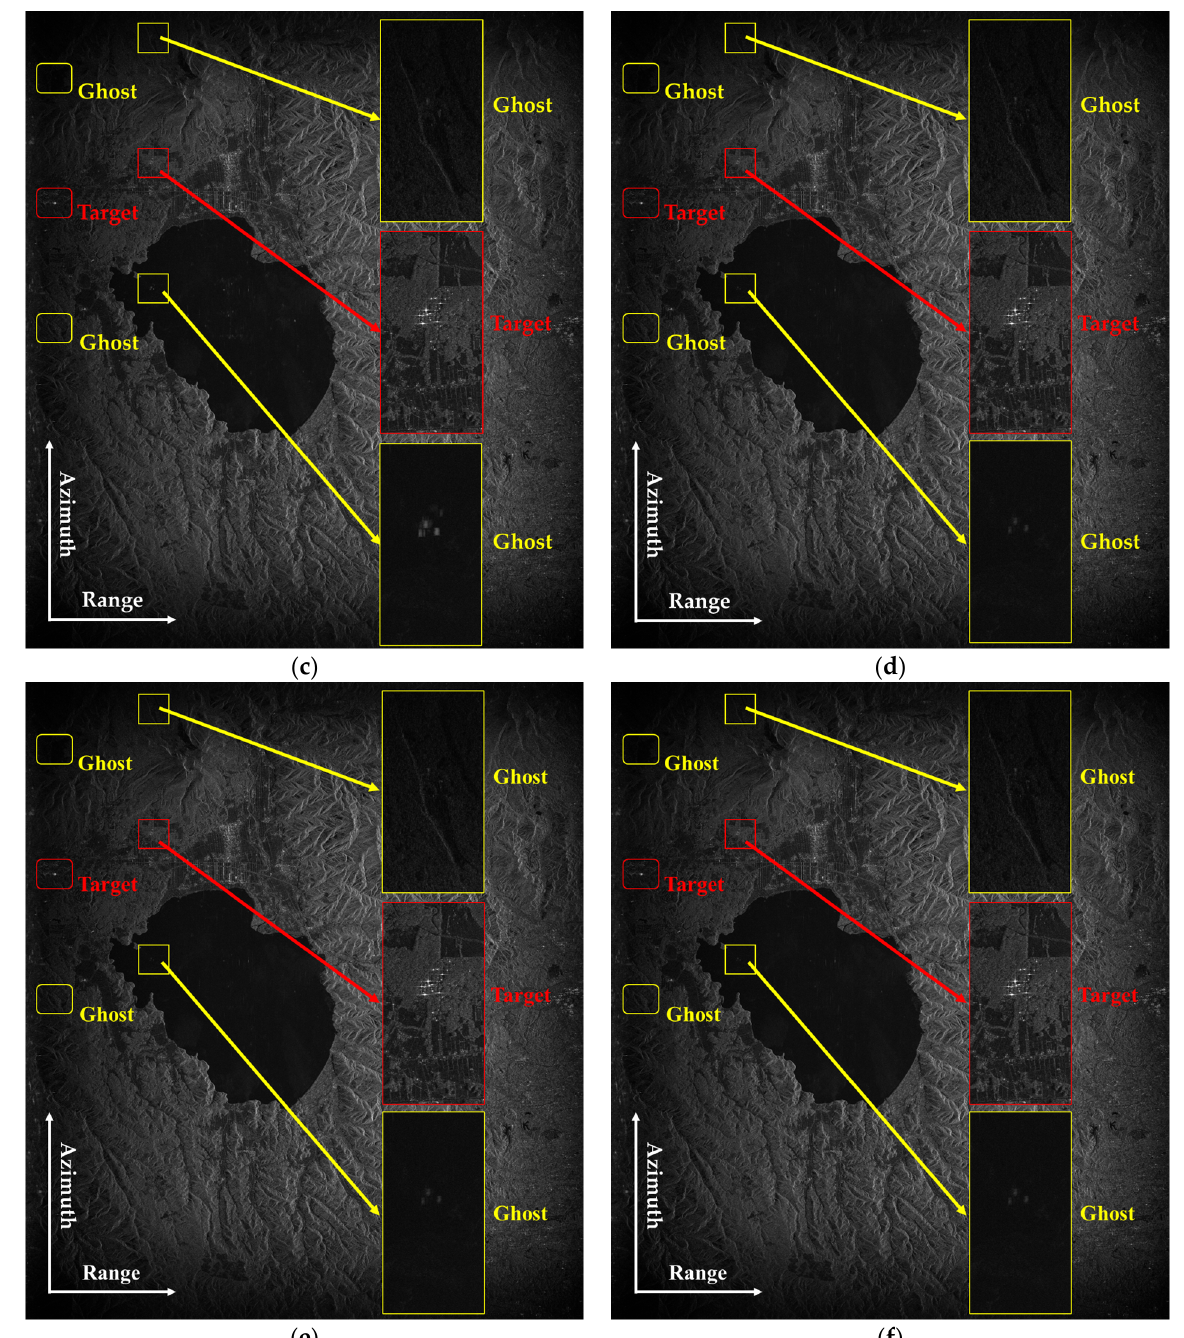
Figure 13. GF-3 two-channel signal imaging results. ( a ) imaging results without phase calibration, ( b ) imaging results after phase calibration using the MVDR method, phase error = 1.96 rad, ( c ) imaging results after phase calibration using the ATC method, phase error = 2.95 rad, ( d ) imaging results after phase calibration using the LLN method, phase error = 2.79 rad, ( e ) imaging results after phase calibration using the method proposed by this paper, phase error = 2.79 rad, and ( f ) imaging results after phase calibration using the method proposed by this paper with 40 times downsampling for reconstructed azimuth spectrum, phase error = 2.79 rad.